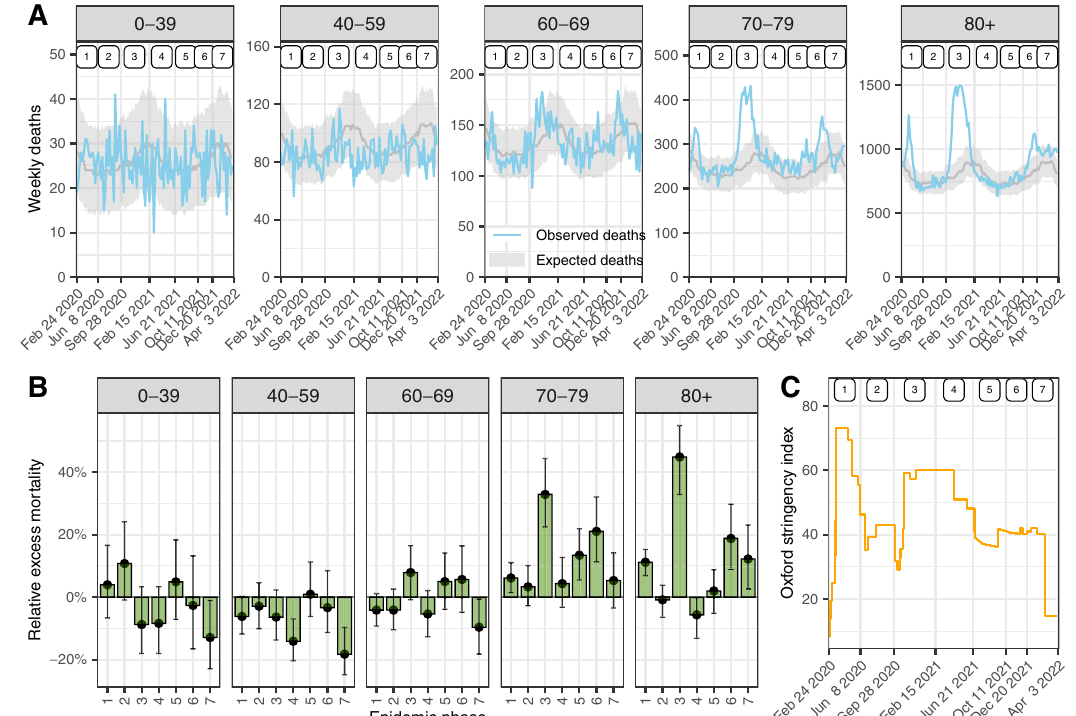
Fig.1|Observedandexpectednumberofdeaths,relativeexcessmortality,and theOxfordstringencyindex.A Observed andexpectednumberof weeklydeaths by age group in Switzerland from February 2020 to April 2022. Model-predicted expected deaths are shown with a median and 95%credibility interval. Numbersat the top indicate epidemic phases 1 – 7. B Estimated relative excess mortality by seven epidemic phases from February 2020 to April 2022 and fi ve age groups.